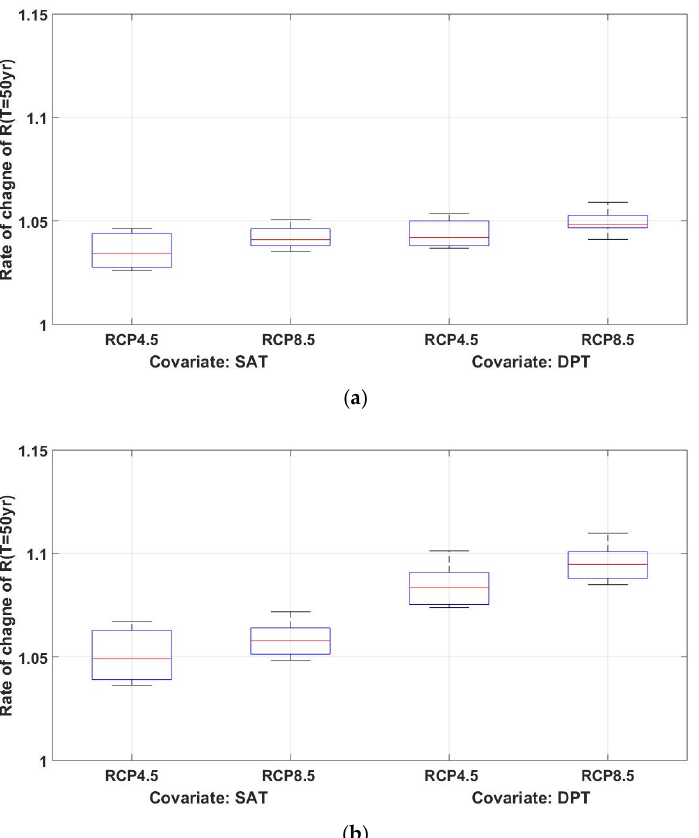
Figure 6. Rate of change of rainfall quantile for return level of 50 years: ( a ) Chuncheon site and ( b ) Cheonan site, using non-stationary models n 1 and n 2 . The rate of change is calculated as the ratio of the rainfall quantile for the future year 2050 to the rainfall quantile for the present period (1981–2010) for each combination of eight climate models.